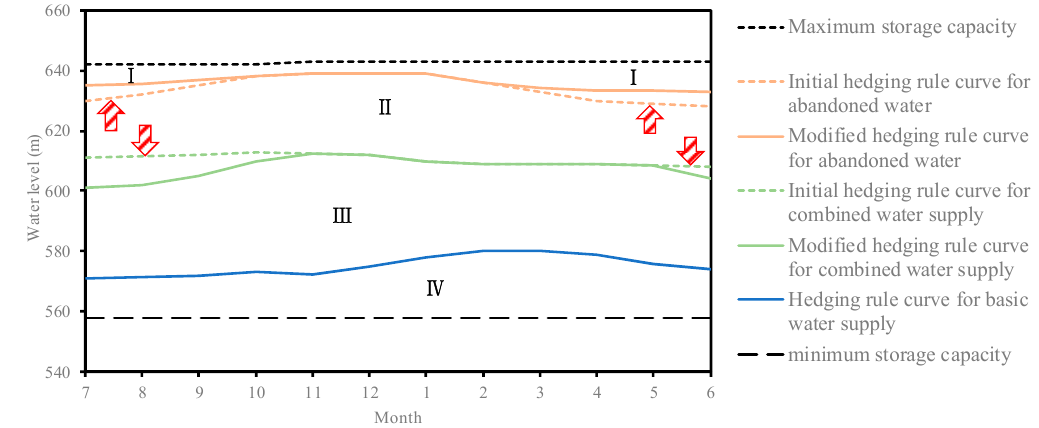
Figure 8. The modified operation chart for the Sanhekou reservoir of the Project. The original interpretation of the operation chart is listed in the supplementary material.